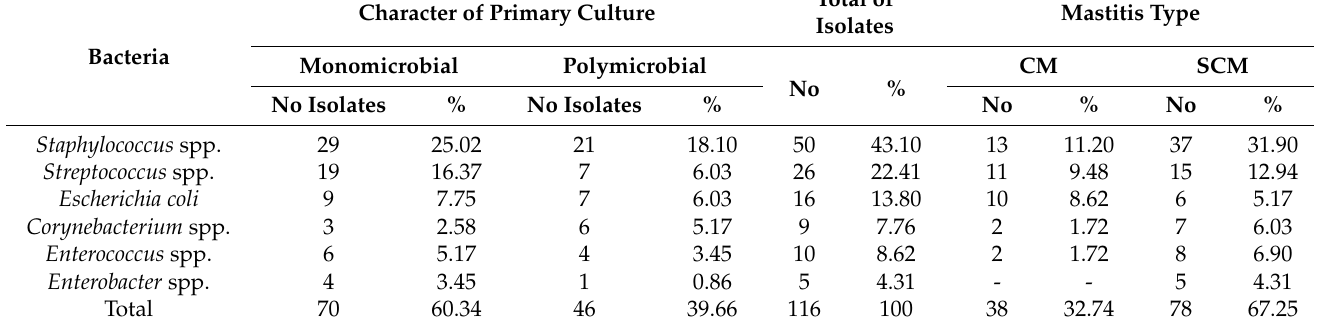
Table 1. Microorganisms isolated from mastitic milk and their distribution depending on the character of primary culture and mastitis evolution type.